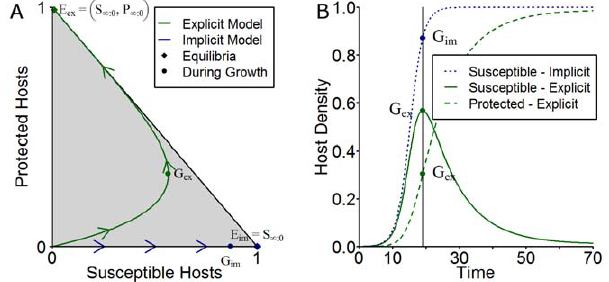
Figure 4. Disease-free growth dynamics. (A) A state space plot of the relative densities of susceptible (S) and protected (P) hosts during the disease free growth period for the explicit and implicit models. The points E ex and E im correspond to the disease-free equilibrium (DFEQ) densities for the explicit and implicit models respectively, and the points G ex and G im correspond to non-equilibrium densities (i.e. densities during the growth stage) of the disease-free states of the explicit and implicit models. (B) The equivalent plot of the densities of susceptible and protected hosts against time for the explicit model along with the equivalent growth curve of susceptible host density for the implicit model. The parameter values used here are given in Table 2.